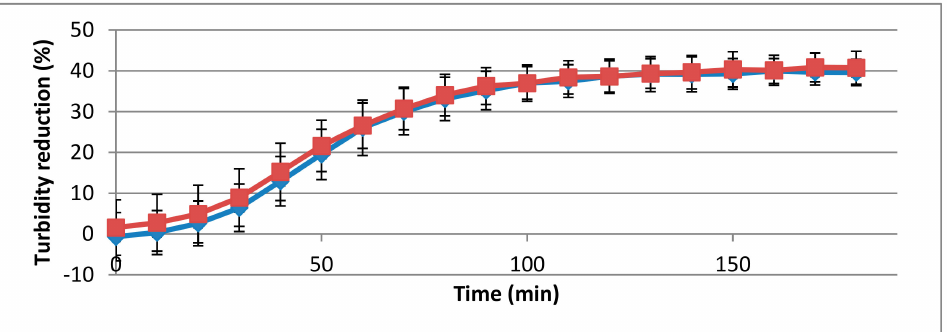
Figure 3. Muralytic activity of the 293-amidase domain (40 µ g / mL) against L. monocytogenes strains 473 (red) and 3099 (blue). Lytic activity datasets are represented as in Figure